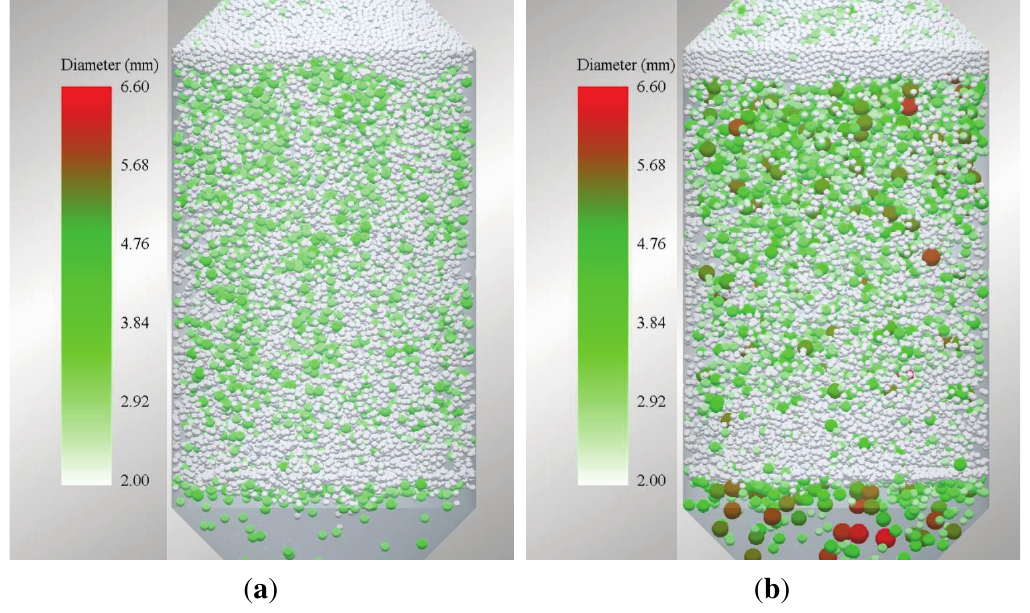
Figure 7. EDEM TM snapshots of particle diameter. ( a ) Particle diameter at time = 1 s; ( b ) Particle diameter at time = 2